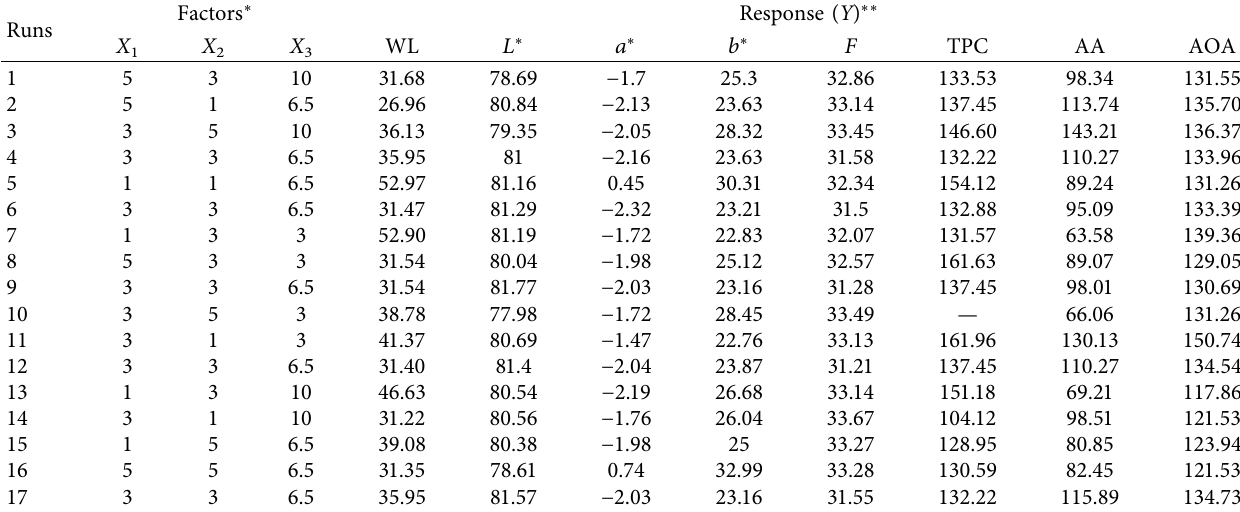
Table 1: Response surface methodology Box-Behnken design of experiment for process factors ( X ) and their responses ( Y ) for beeswax coating.